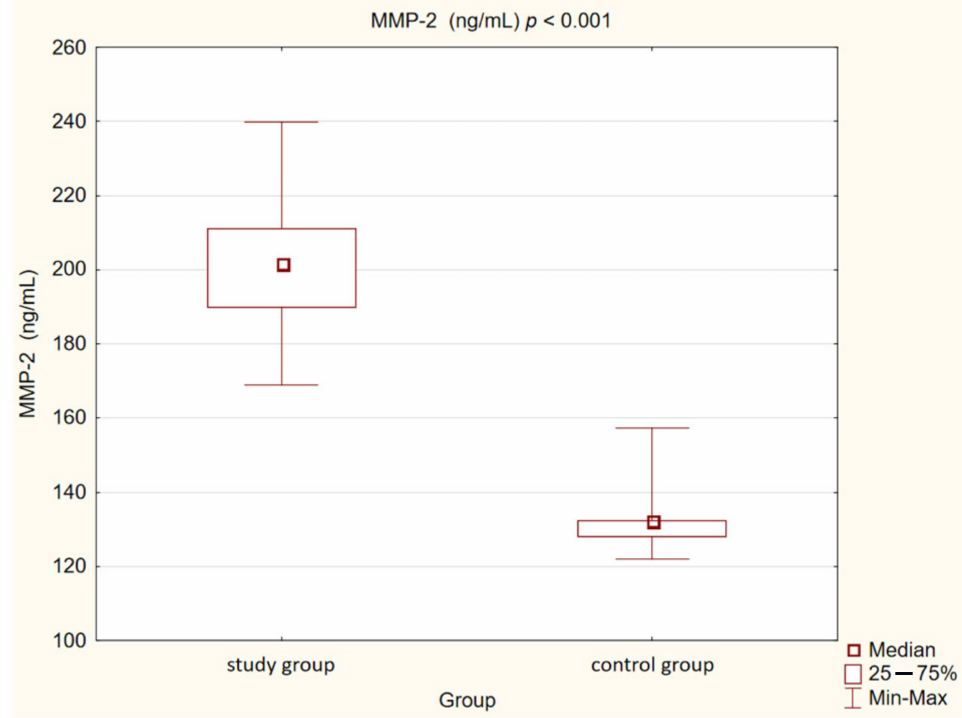
Figure 7. Concentration of metalloproteinase 2 (MMP-2) in study and control group.